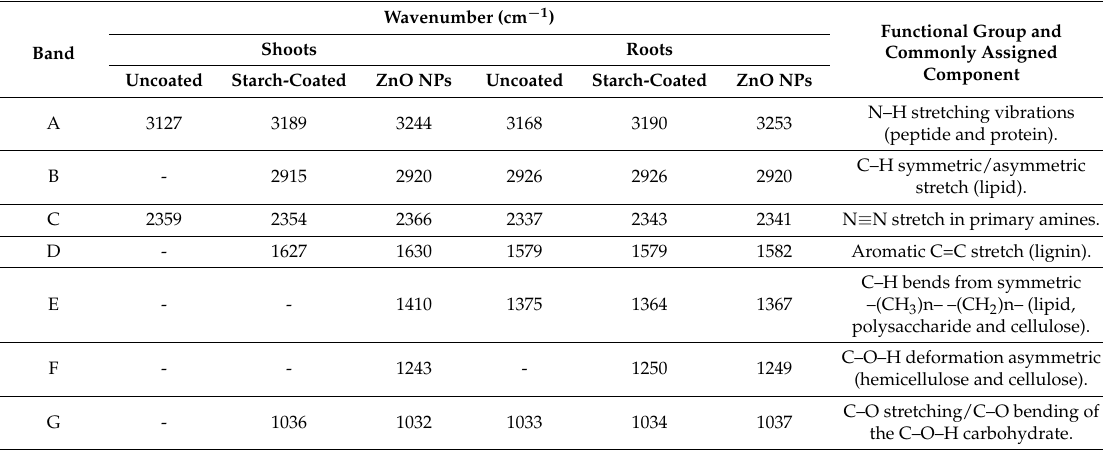
Table 3. Band assignments of the main active vibrations present in the FTIR-ATR spectra of maize shoots and roots.